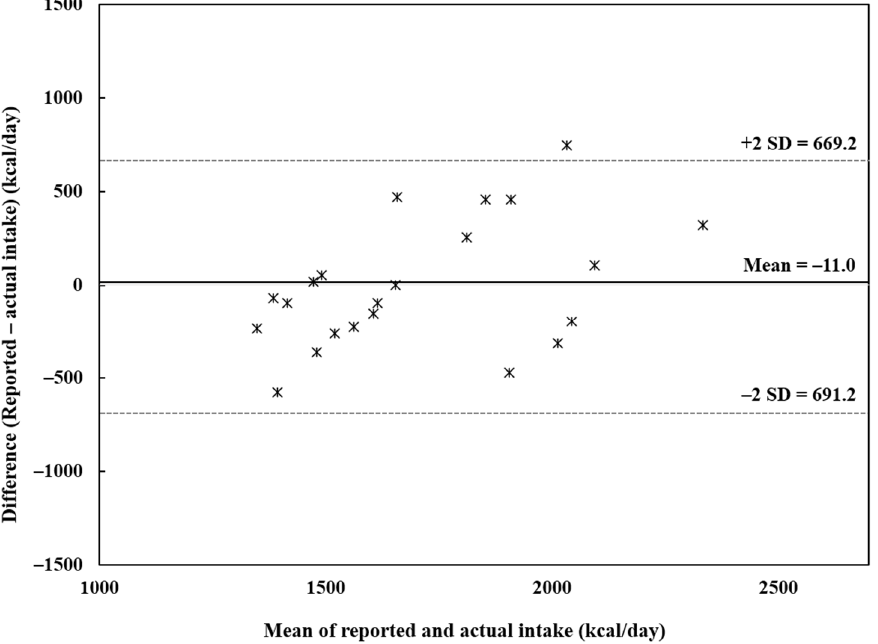
Figure 1. Bland–Altman plot for the reported and actual energy intake among older Korean women ( n = 22) Symbols represent each individual. SD: standard deviation.